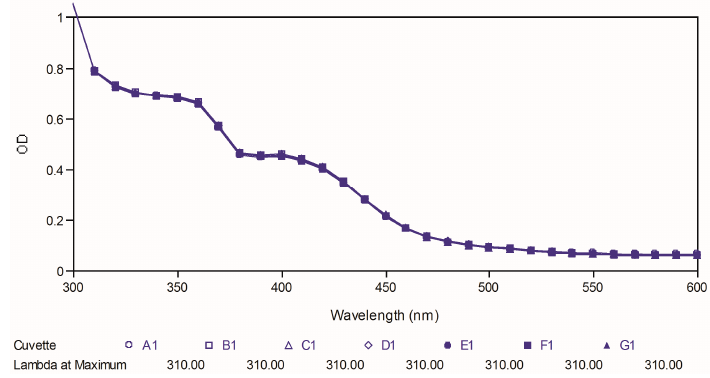
Figure 10. Ultraviolet-visible absorption spectra of compound 97